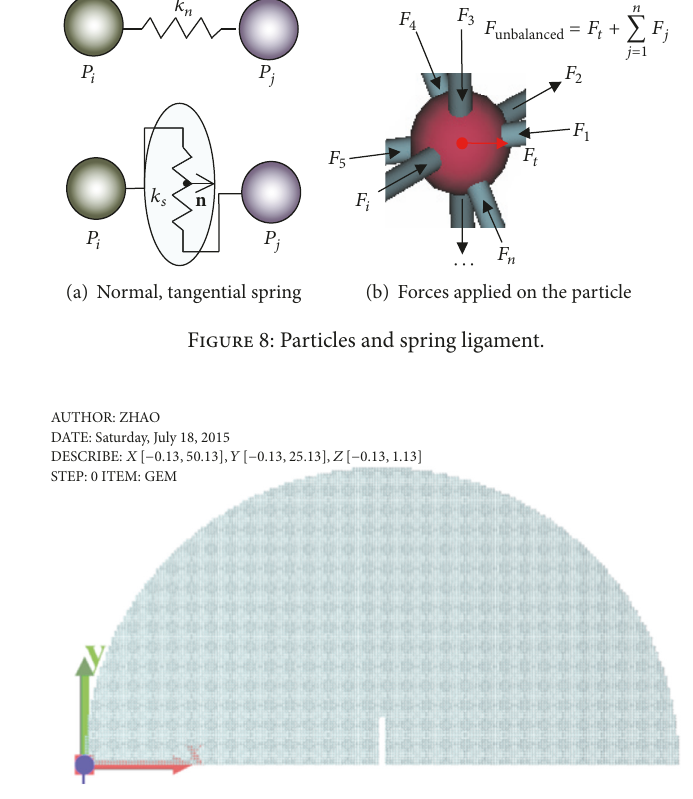
Figure 9: Model of NSCB